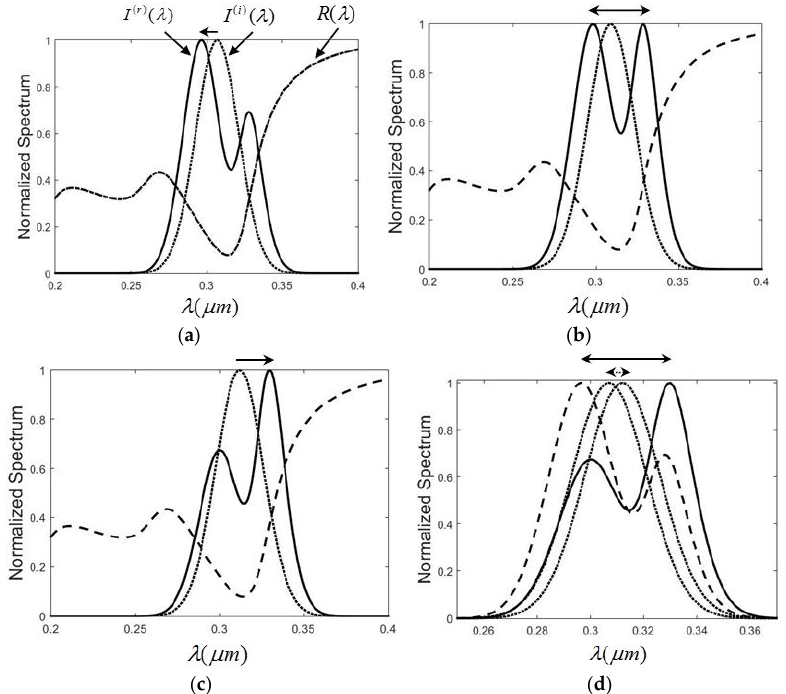
Figure 5. The normalized spectrum of I ( i ) (λ) (dotted line), I ( r ) (λ) (solid line), and R (λ) (dashed line) for three incremental λ c . ( a ) λ c = 0.307 µm; ( b ) λ c = 0.310 µm; ( c ) λ c = 0.312 µm. The shift of the spectrum maximum is indicated by the arrows on the top of the figure; ( d ) The spectral shift amplification (SSA) effect with Ag. The SSA factor is 6.5.